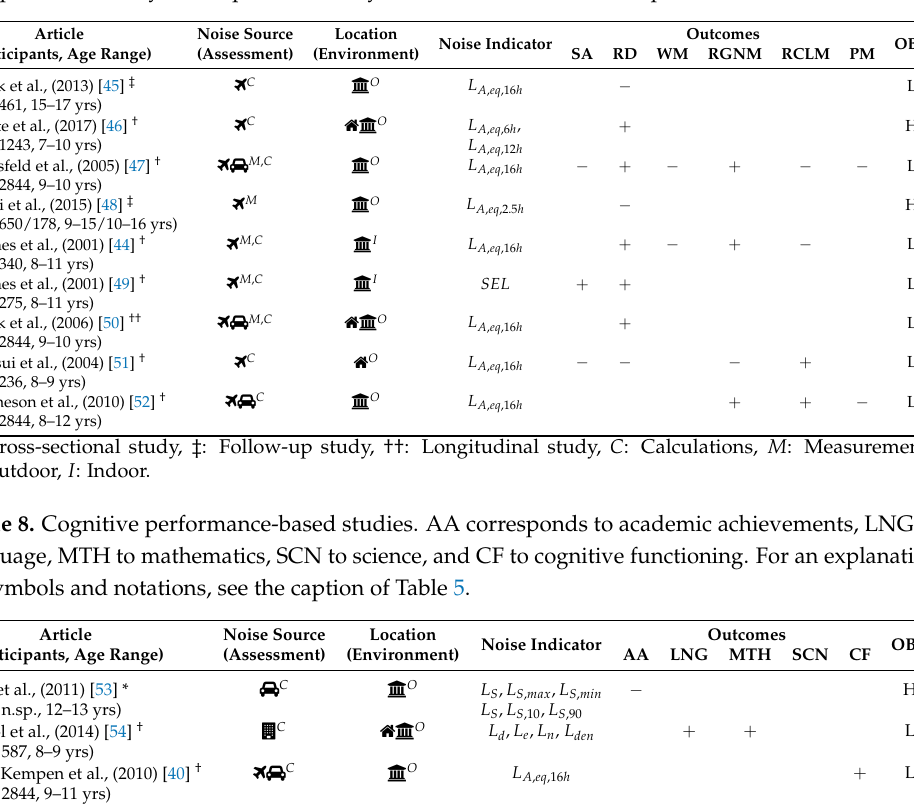
Table 7. Cognitive development-based studies. SA corresponds to sustained attention, RD to reading, WM to working memory, RGNM to recognition memory, RCLM to recall memory, and PM to prospective memory. For explanation of symbols and notations, see caption of Table 5.